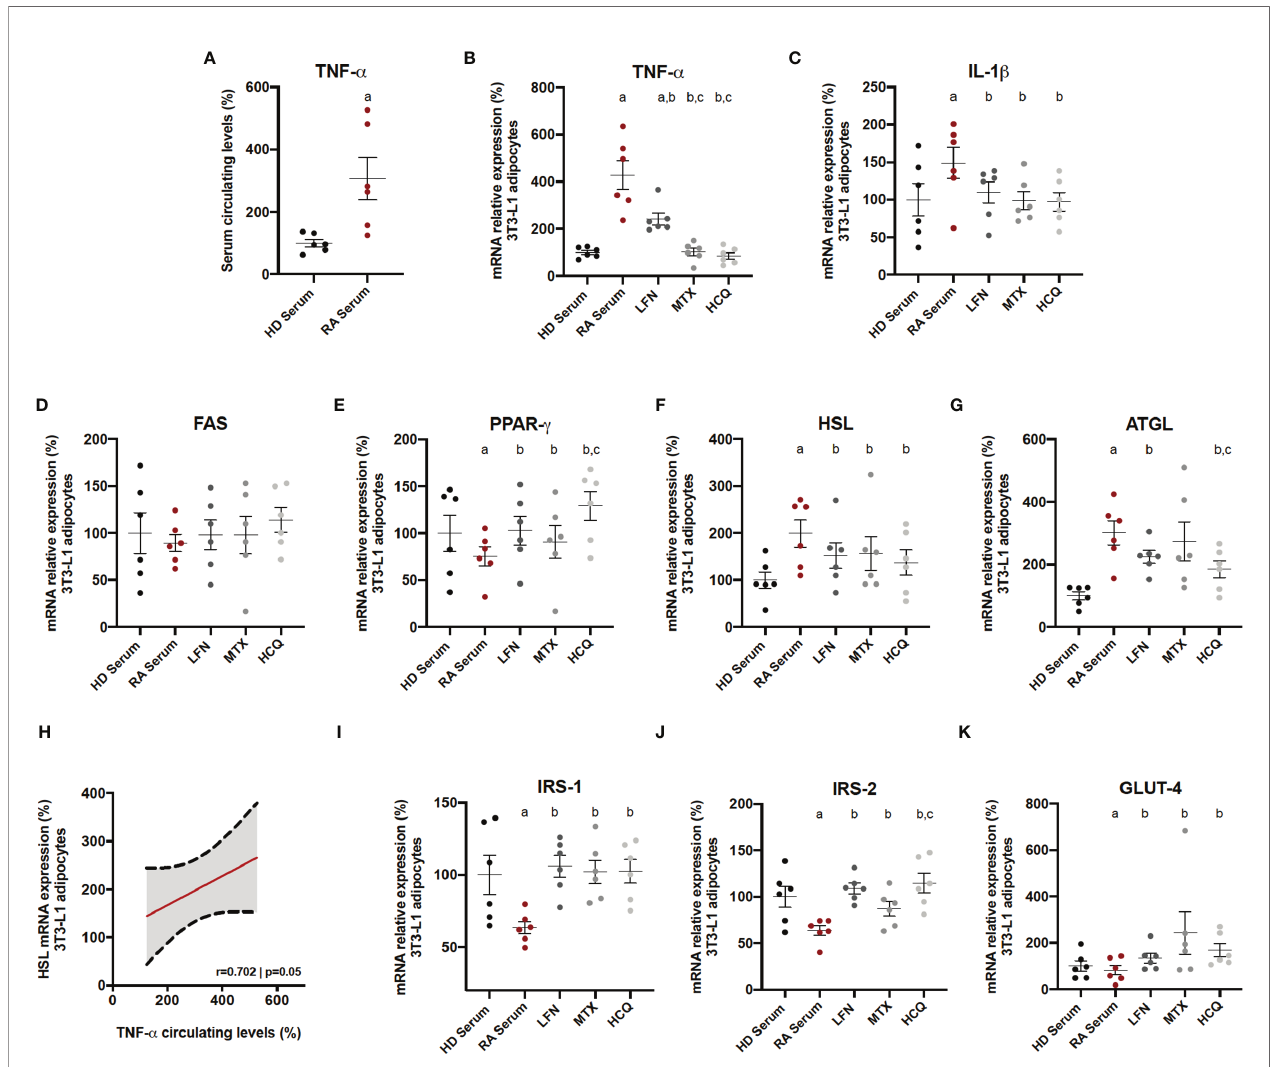
FIGURE 7 | In vitro effects of cDMARDs in adipocyte-activated RA serum. (A) Levels of TNF- a in serum from six healthy donors and six RA patients. (B) mRNA relative expression of TNF- a in 3T3-L1-derived adipocytes after 24 h of treatment with LFN, MTX, and HCQ. (C) mRNA relative expression of IL-1 b in 3T3-L1 derived adipocytes after 24 h of treatment with LFN, MTX, and HCQ. (D) mRNA relative expression of FAS in 3T3-L1-derived adipocytes after 24 h of treatment with LFN, MTX, and HCQ. (E) mRNA relative expression of PPAR g in 3T3-L1 derived adipocytes after 24 h of treatment with LFN, MTX, and HCQ. (F) mRNA relative expression of HSL in 3T3-L1-derived adipocytes after 24 h of treatment with LFN, MTX, and HCQ. (G) mRNA relative expression of ATGL in 3T3-L1-derived adipocytes after 24 h of treatment with LFN, MTX, and HCQ. (H) Correlation between the mRNA expression of HSL in 3T3-L1 adipocytes and the levels of TNF- a in the RA serum. (I) mRNA relative expression of IRS-1 in 3T3-L1-derived adipocytes after 24 h of treatment with LFN, MTX, and HCQ. (J) mRNA relative expression of IRS-2 in 3T3-L1-derived adipocytes after 24 h of treatment with LFN, MTX, and HCQ. (K) mRNA relative expression of GLUT-4 in 3T3-L1-derived adipocytes after 24 h of treatment with LFN, MTX, and HCQ. HD, healthy donor; RA, rheumatoid arthritis; TNF- a , tumor necrosis factor alpha; IL-1 b , interleukin 1 beta; FAS, fatty acid synthase; PPAR g , peroxisome proliferator activated receptor gamma; HSL, hormone sensitive lipase; ATGL, adipose triglyceride lipase; IRS-1, insulin receptor substrate 1; IRS-2, insulin receptor substrate 2; GLUT-4, glucose transporter type 4. Signi fi cance was determined by one-way ANOVA followed by Ducan post hoc test (A – G, I – K) . a Signi fi cant differences vs. treatment with HD serum (p < 0.05). b Signi fi cant differences vs. treatment with LFN (p < 0.05). c Signi fi cant differences vs. treatment with MTX (p <